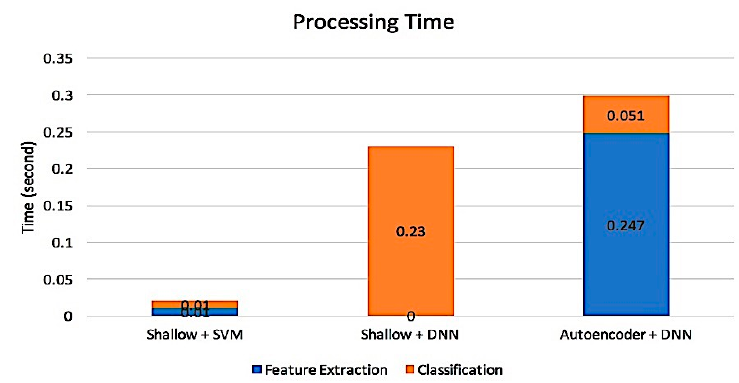
Appl. Sci. 2019 , 9 , x Figure 7. Processing time based on 3 classifiers, SVM, DNNs and DL. Figure 7. Processing time based on 3 classifiers, SVM, DNNs and DL.